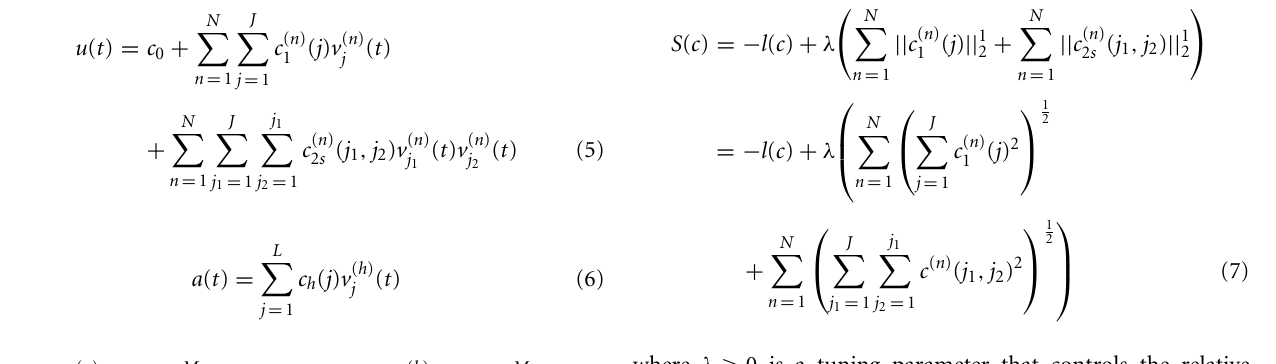
respectively. They are chosen to be 2 s in this study. Second-order cross kernels and higher-order (e.g., third-order) kernels are not included in this